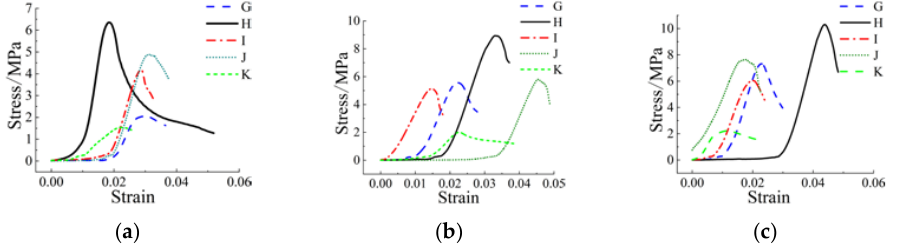
Figure 7. Stress–strain curves at the same age. ( a ) 7 d; ( b ) 14 d; ( c ) 28 d. Table 6. Compressive strength of NUC-FM cube specimen.